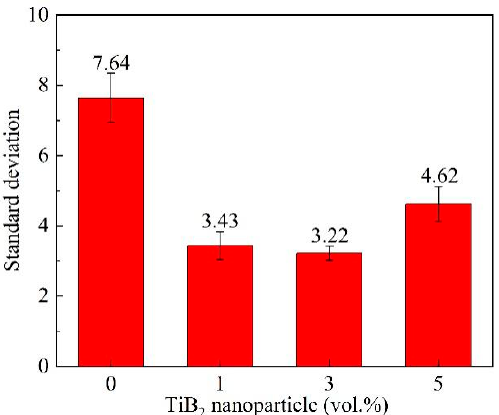
Figure 4. Standard deviation ( S ) of distribution uniformity of the primary Mg 2 Si phases.